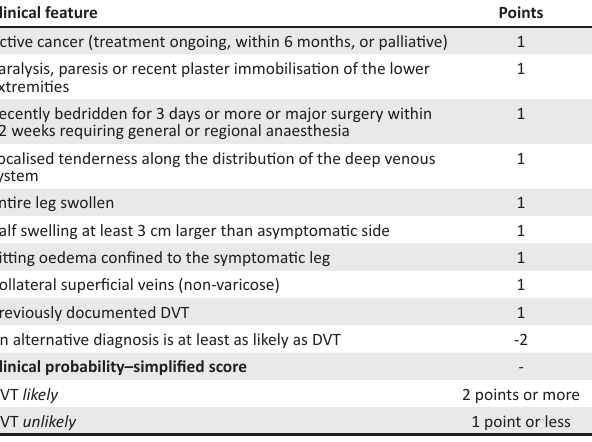
TABLE 1: The modified Wells scoring chart. Clinical feature Points